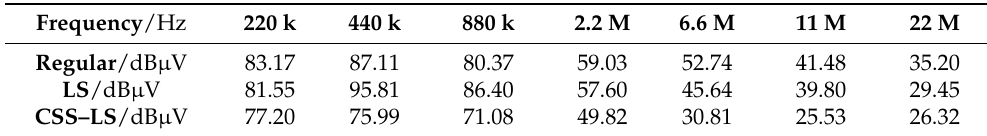
Figure 13. CM EMI spectrum. Table 2. CM EMI spectrum at multiples of the switching